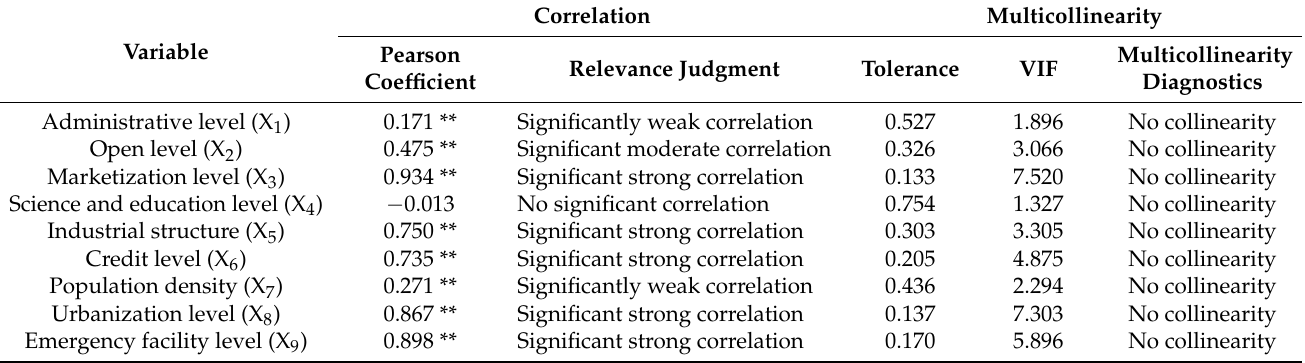
Table 3. Explanatory Variable Correlation and Multicollinearity Tests (Note: 1. The dependent variable is urban resilience; 2. ** implies critical at the level of 0.01; 3. According to the score of correlation coefficient, (0.7, 1) is strong correlation, (0.3, 0.7) is medium correlation, (0, 0.3) is